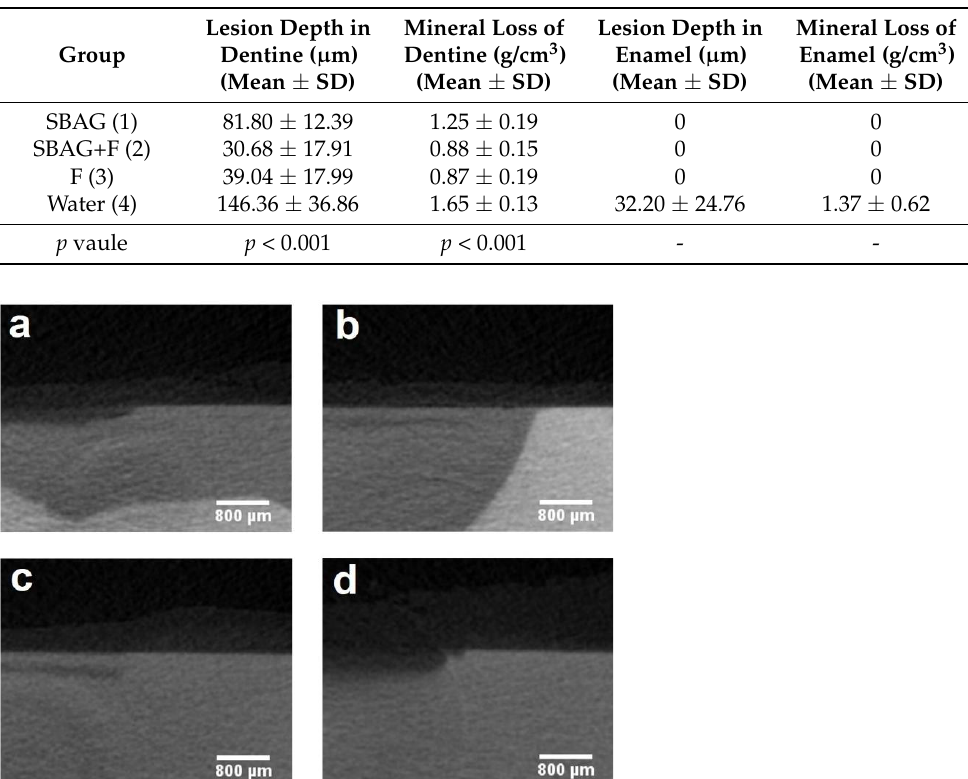
Figure 4. Micro-CT images of dentine in four groups: ( a ) Group 1 (SBAG); ( b ) Group 2 (SBAG+F); ( c ) Group 3 (F); ( d ) Group 4 (Control).